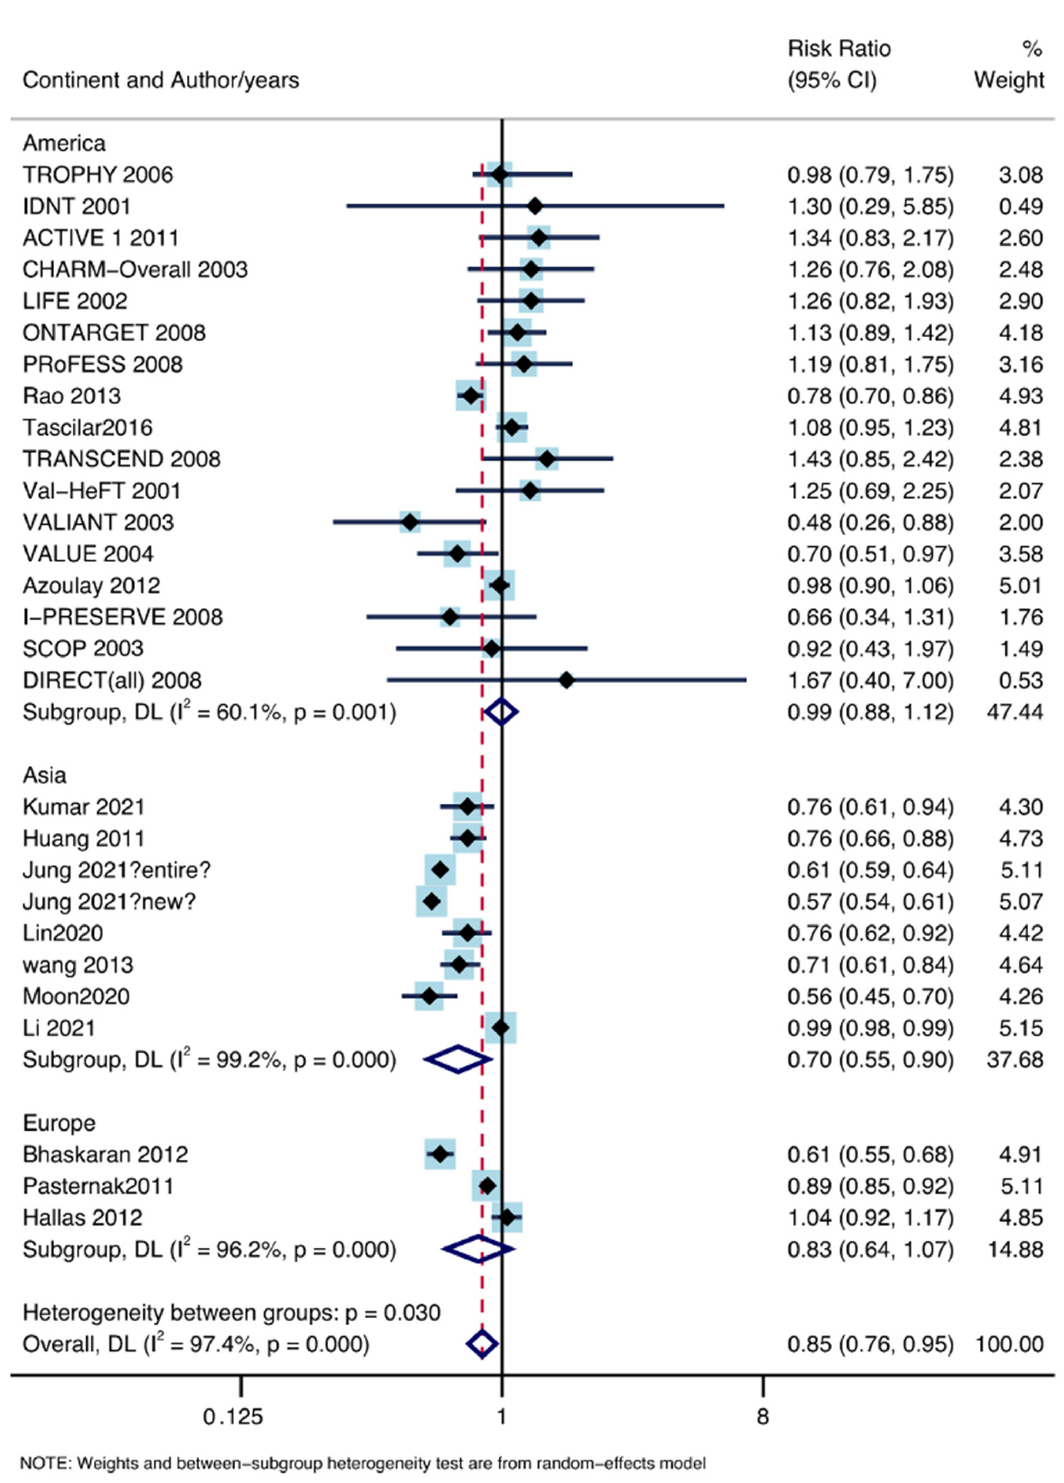
Figure 9. Subgroup analysis by continent.